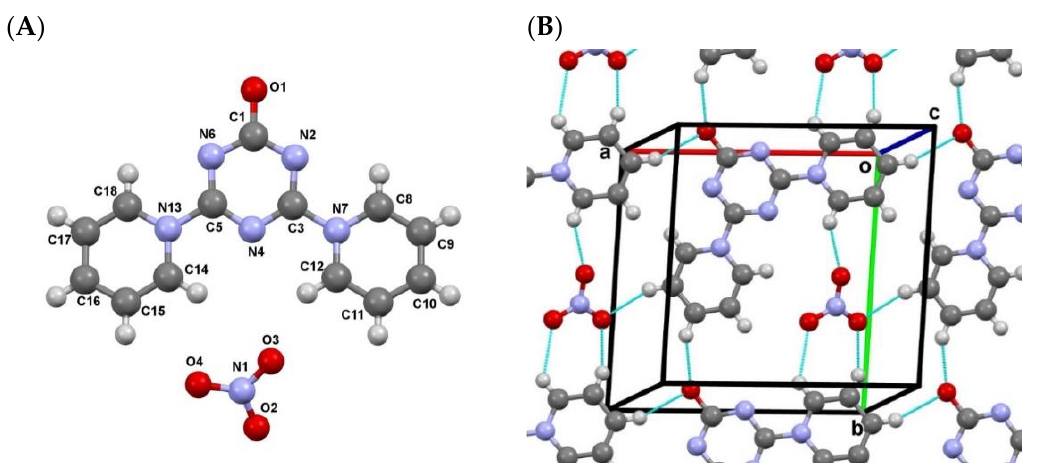
Figure 3. ( A ) Content of the asymmetric unit of 4b showing the atomic numbering; ( B ) a portion of the crystal packing of 4b showing the intermolecular C- H…O hydrogen bonds (cyan thin lines), which link the cations and anions into sheets parallel to the ab planes.